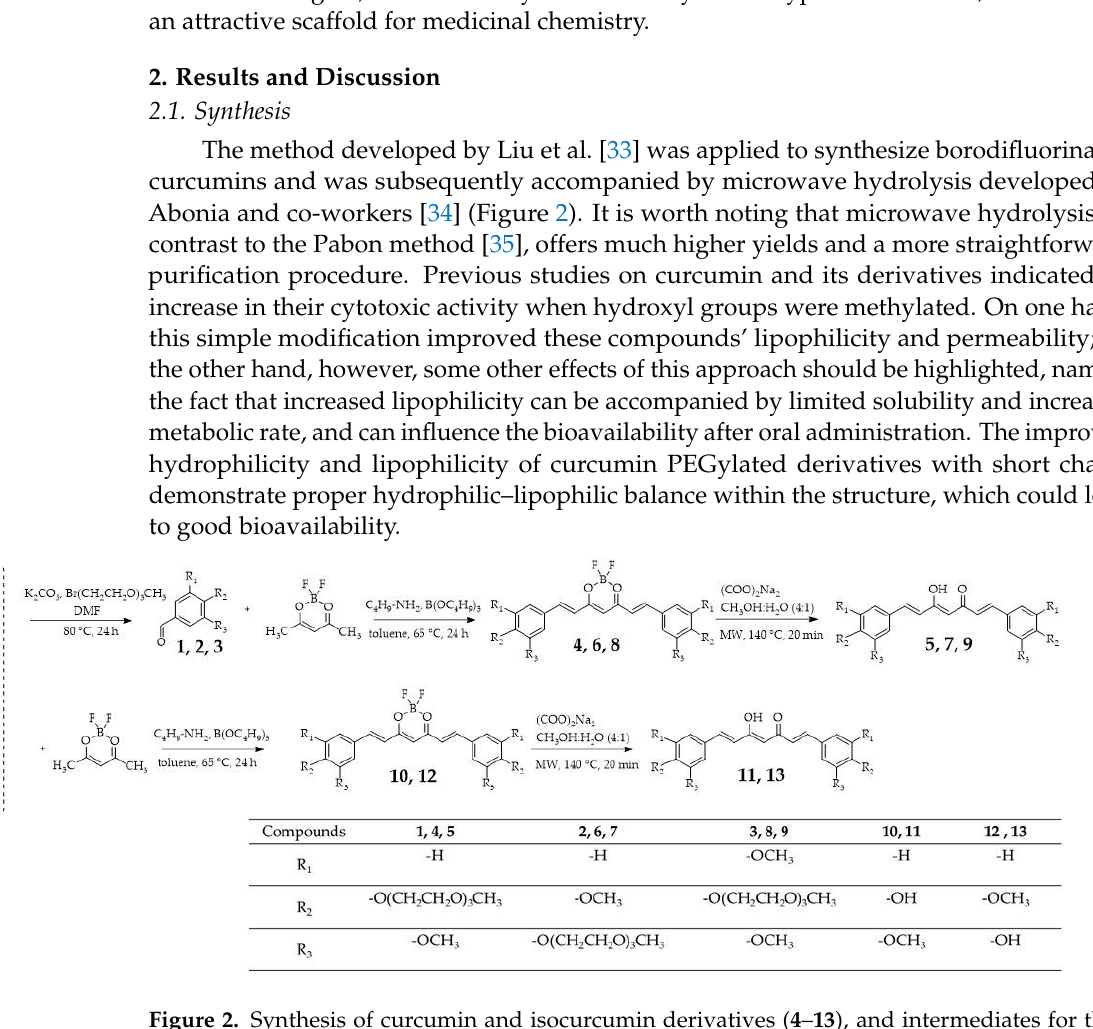
Figure 2. Synthesis of curcumin and isocurcumin derivatives ( 4 – 13 ), and intermediates for their synthesis ( 1 – 3 ). The aromatic aldehyde PEGylation (compounds 1 , 2 , and 3 ) was performed using the nucleophilic substitution method. The borodifluorinated derivatives (compounds 4 , 6 , 8 , 10 , and 12 ) were synthesized according to the method presented by Liu et al. [33], and derivatives with unmodified diketo moiety (compounds 5 , 7 , 9 , 11 , and 13 ) were obtained by microwave hydrolysis developed by Abonia et al. [34]. Abbreviations: DMF, dimethylformamide; MW,